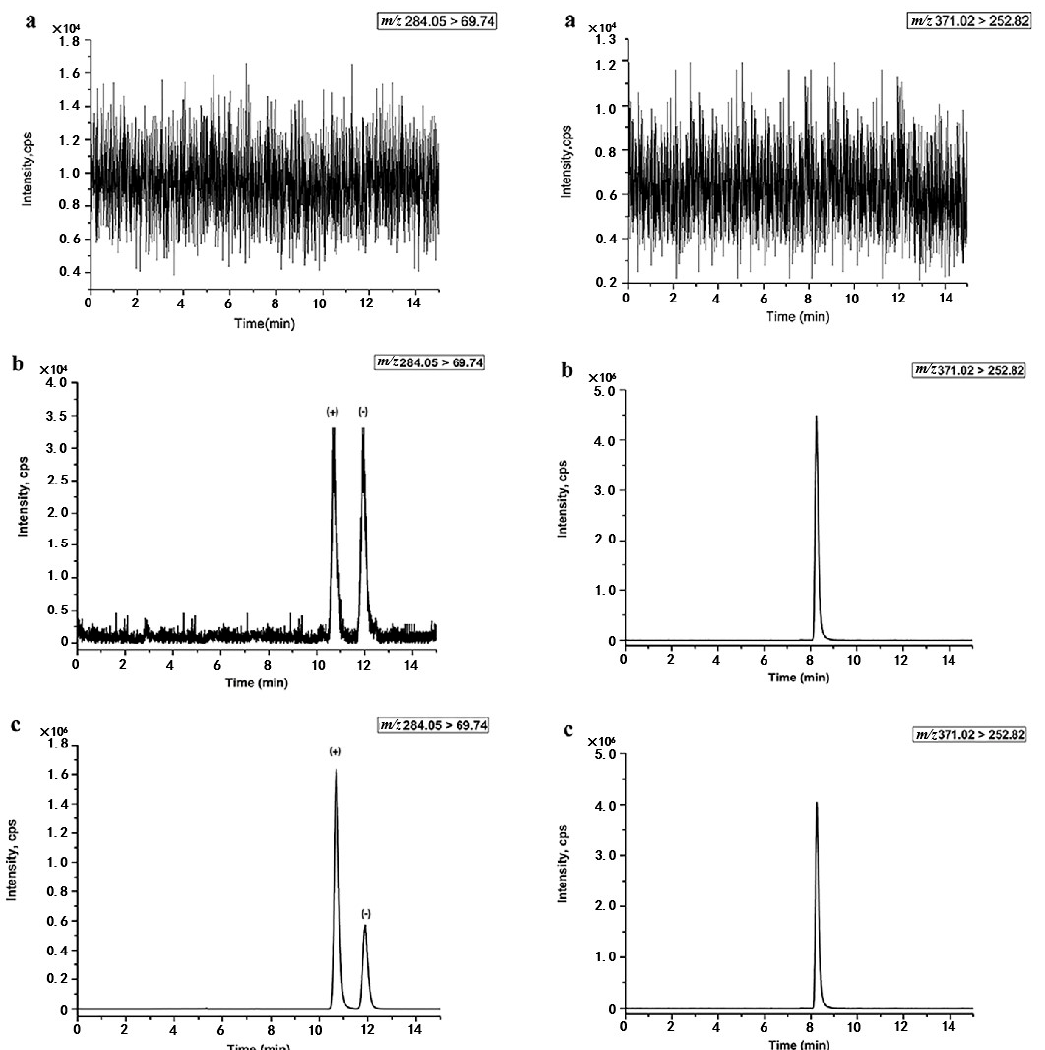
Figure 2. Typical chromatograms of ( + )-and ( − )-penconazole with L-lansoprazole (IS) in rat plasma sample. ( a ) Blank plasma sample; ( b ) blank plasma sample spiked with penconazole enantiomers at the lower limit of quantification (LLOQ) level; ( c ) extracted rat plasma sample at 2 h after single oral administration of 50 mg · kg − 1 rac-penconazole to female rats.